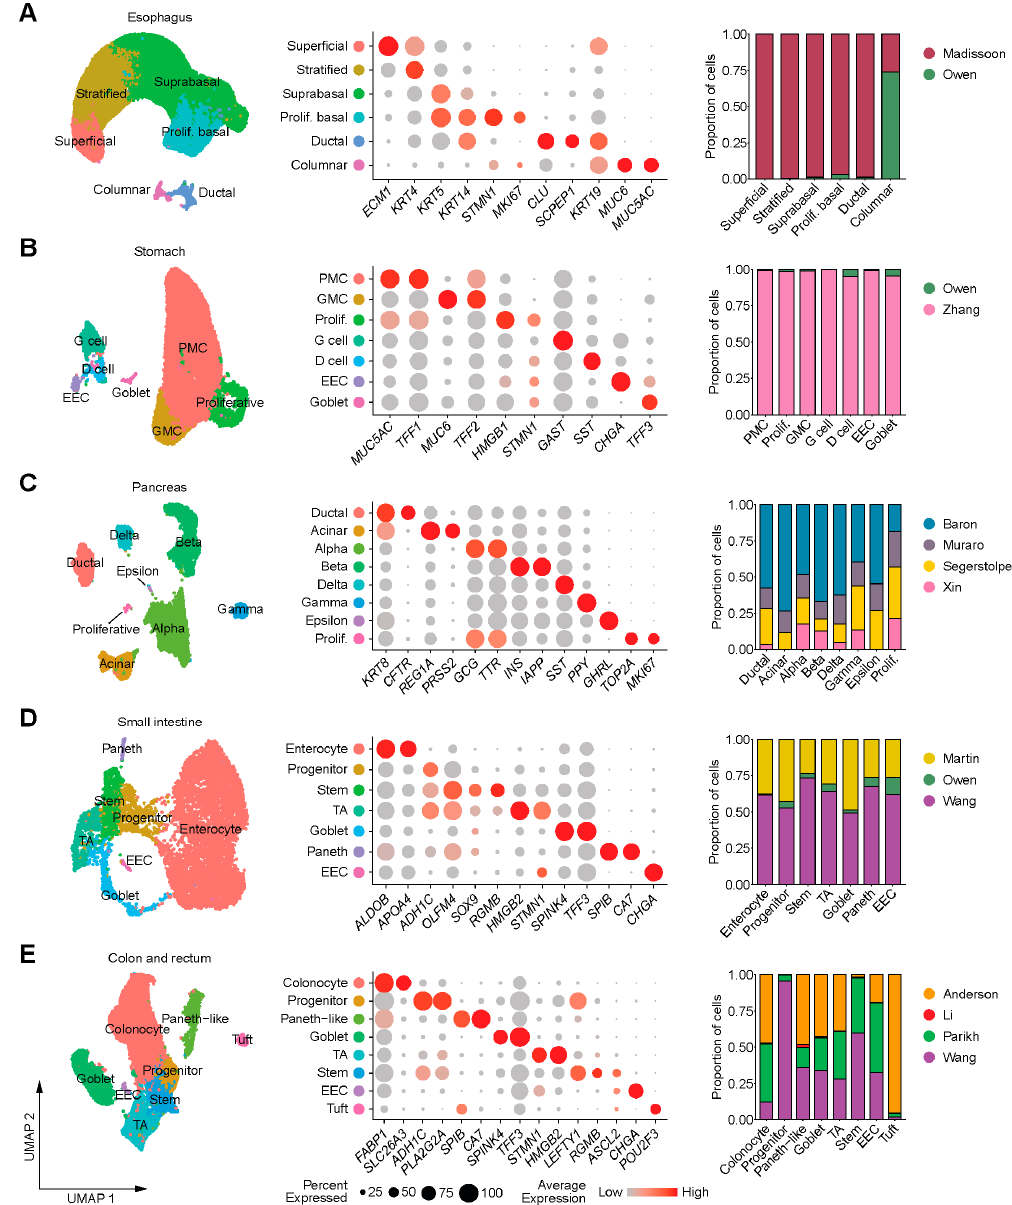
Figure 1. Uniform manifold approximation and projection (UMAP) plots (left) of single-cell RNA-seq (scRNA-seq) data from ( A ) esophagus, ( B ) stomach, ( C ) pancreas, ( D ) small intestine and colon and ( E ) rectum; bubble plots showing expression levels of cell-type marker genes (middle) and bar plots depicting the distribution of different datasets in each cell type (right). EEC: Enteroendocrine cell, GMC: Antral basal gland mucous cell, PMC: Pit mucous cell, Prolif: Proliferative, TA: Transit-amplifying cell.